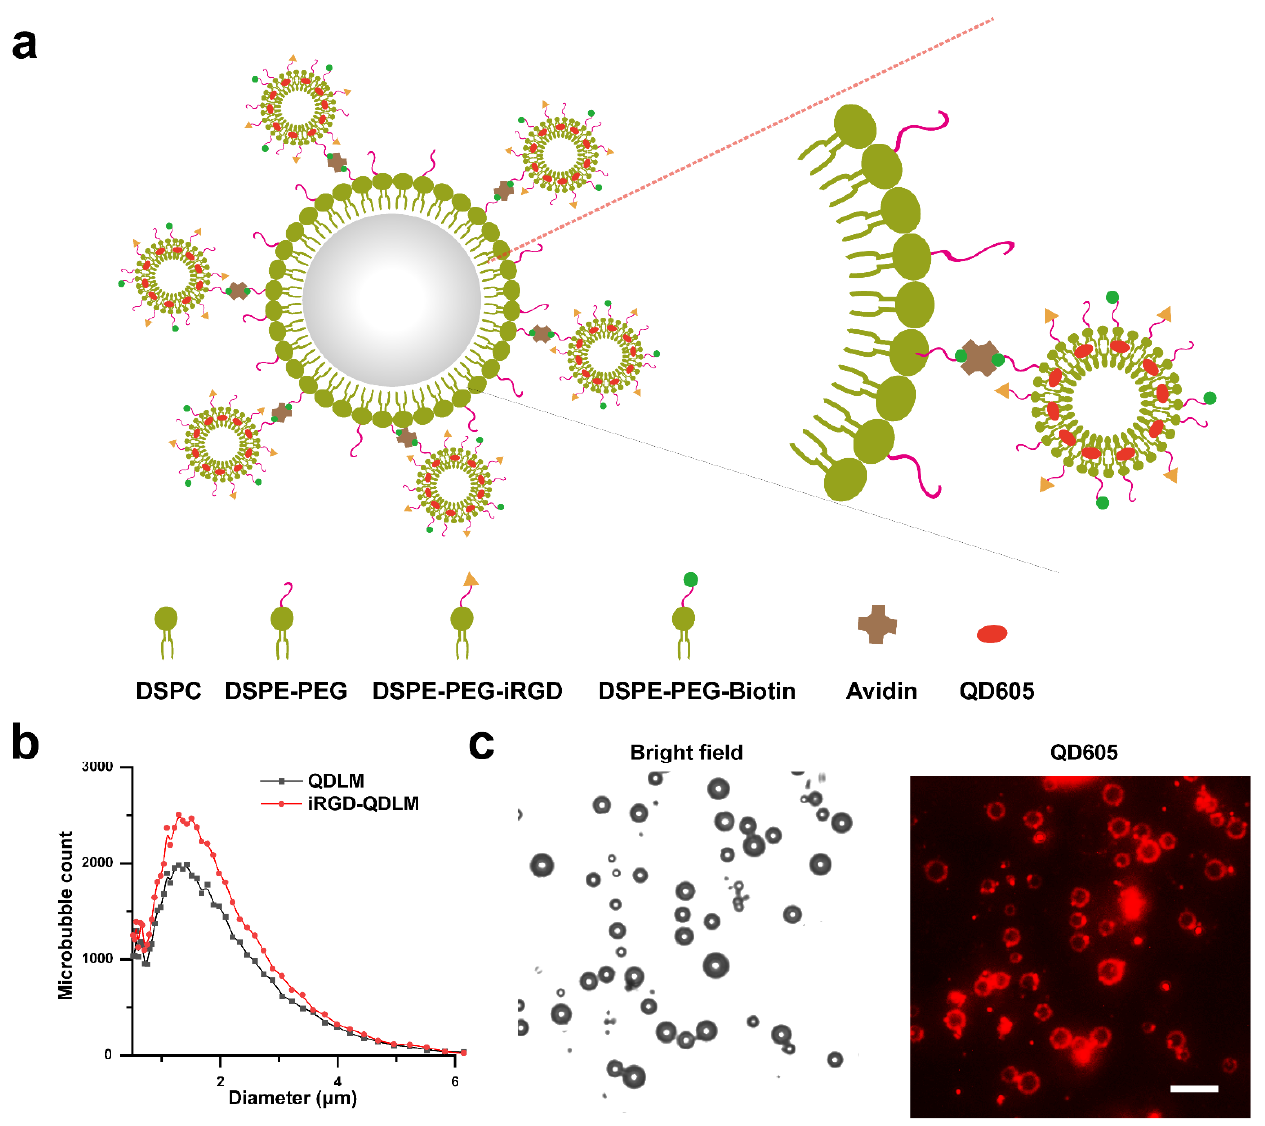
Figure 2. Preparation and characterization of iRGD-QDLM. ( a ) Schematic diagram of iRGD-QDLM. Biotinylated liposomes containing QD are adhered to the surface of biotinylated MBs via biotin– avidin system. ( b ) Size distribution of iRGD-QDLM and QDLM. ( c ) Light micrograph of iRGD-QDLM (scale bar: 10 µ m), revealing good dispersity and QD-liposomes attached to the surface of MBs.